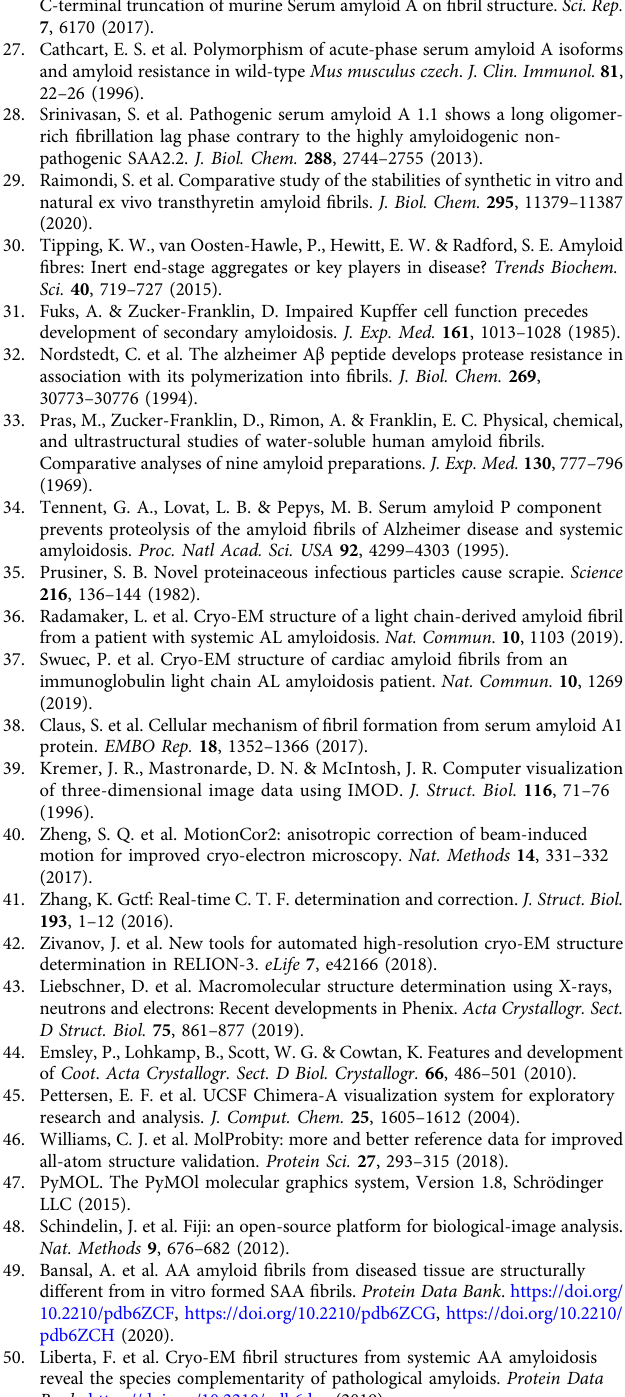
Fig. 1: PDB 6DSO 50 . The data that support the fi ndings of this study are available from the corresponding author upon reasonable request. The source data associated with following fi gures are provided with this paper: Fig. 5, Supplementary Figs. 1, 4, and 7. The unique materials used in this study are available from the corresponding author on reasonable request. Source data are provided with this